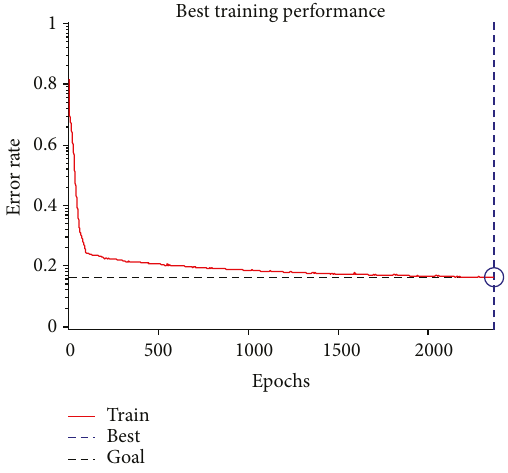
Figure 10: Network training of template engineering.